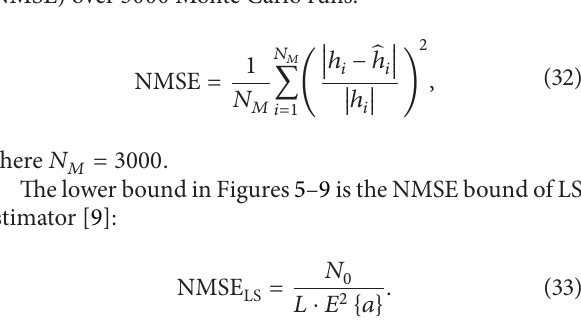
The 𝑦 -axis shows the normalized mean-square error